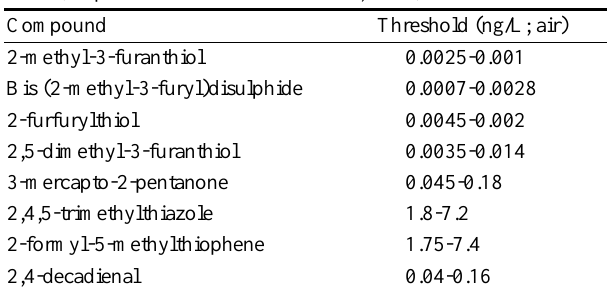
Table 3. Odour thresholds of some volatiles identified in boiled meat (adapted from Gasser and Grosch, 1990) Compound